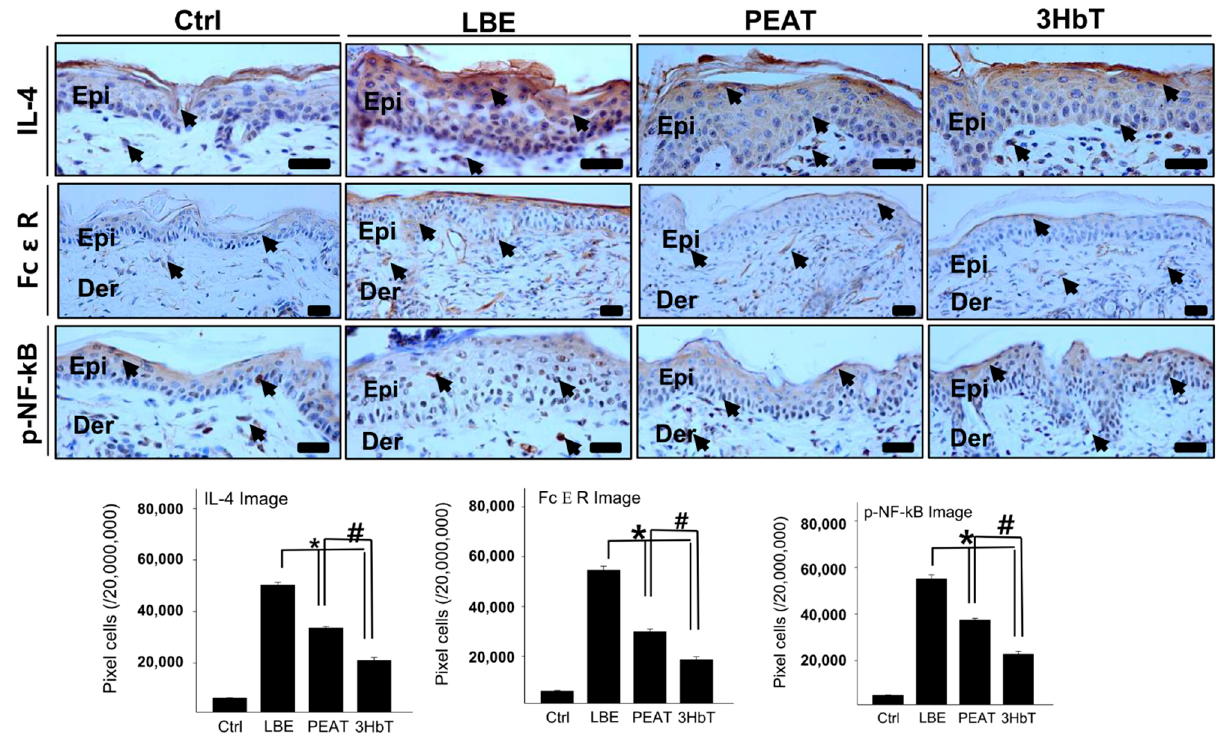
Figure 5. The regulation of the Th2 skewed condition using Three Herb (3Hb) extract. The expression of IL-4, Fc ε R, p-NF- κ B (light brown particles indicated by arrows) was significantly lower in 3HbT compared to PEAT and LBE (immunohistochem- istry; bar size, 50 µm). The data of image analysis for positive reactions showed the same results. 3Hb, Rhizome of Coptis chinensis , Rhizome of Glycyrrhiza uralensis , and fermented Semen of Glycine max ; Ctrl, the normal group; LBE, lipid barrier elimination group; 3HbT, 3Hb treated group after lipid barrier elimination; IL-4, interleukin-4; Fc ε R, Fc ε receptor; p-NF- κ B, phosphate-nuclear factor- κ B; Epi, epidermis; Der, dermis; * p < 0.05 compared to LBE; # p < 0.05 compared to PEAT.